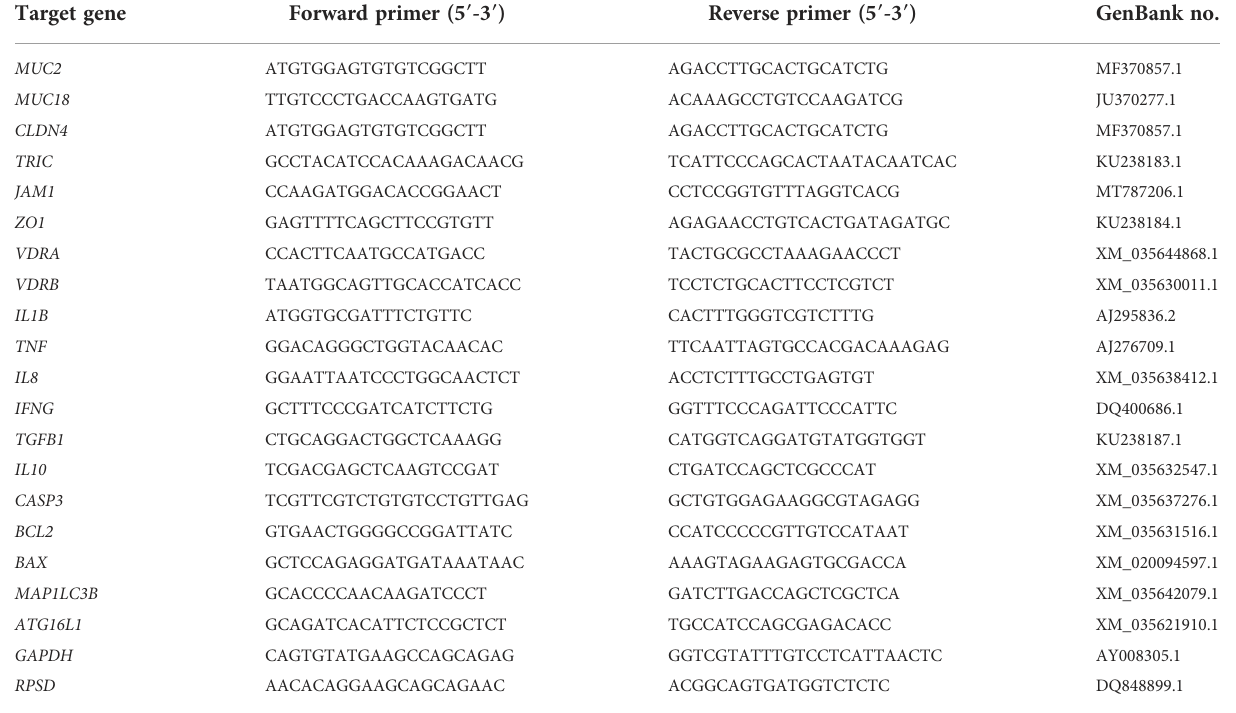
TABLE 3 Primers used in quantitative real-time PCR